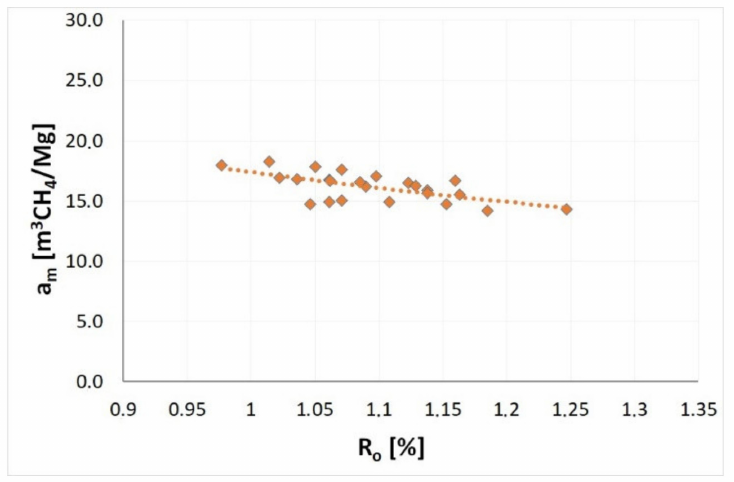
Figure 6. The impact of coalification degree on the maximum methane sorption capacity of coal ( a m